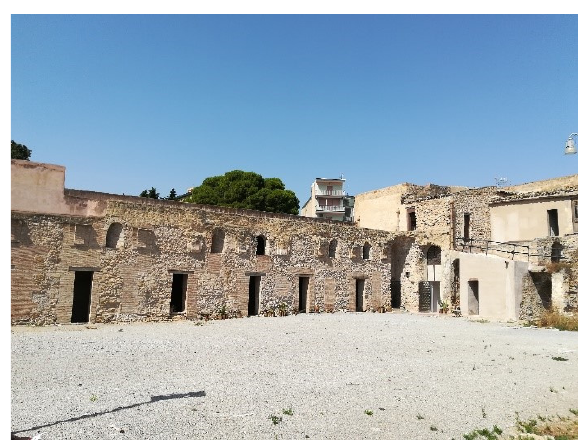
Figure 4. View of the internal courtyard of the